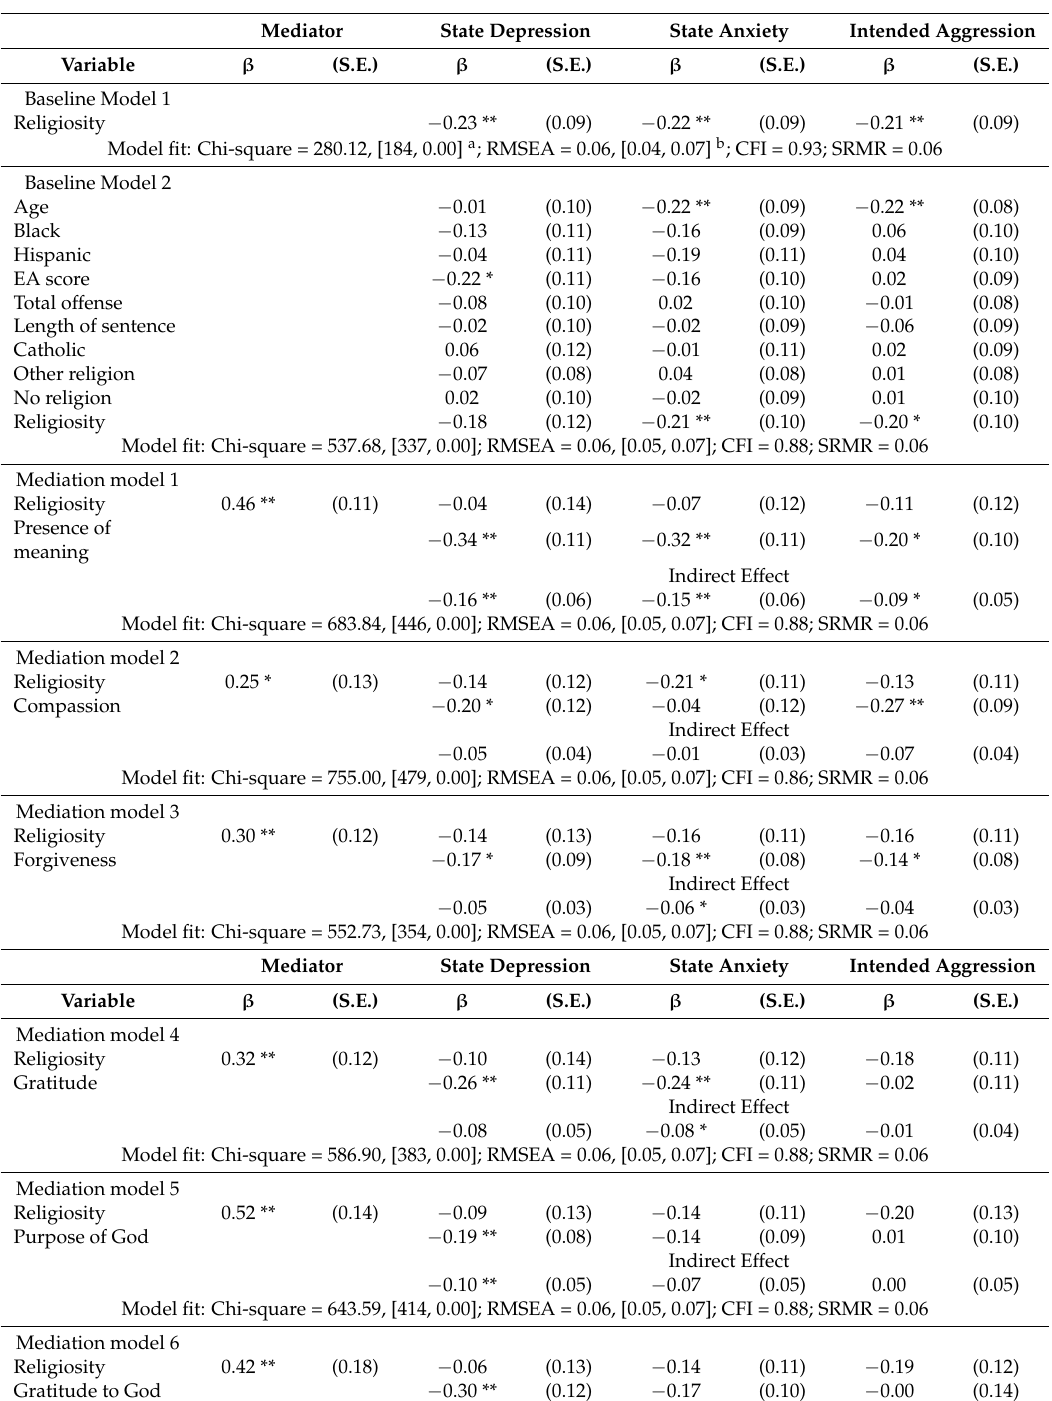
Table 2. Baseline and Mediation Models of State Depression, State Anxiety, and Intended Aggression ( n = 163); with Standardized Coefficients and Standard Errors (in